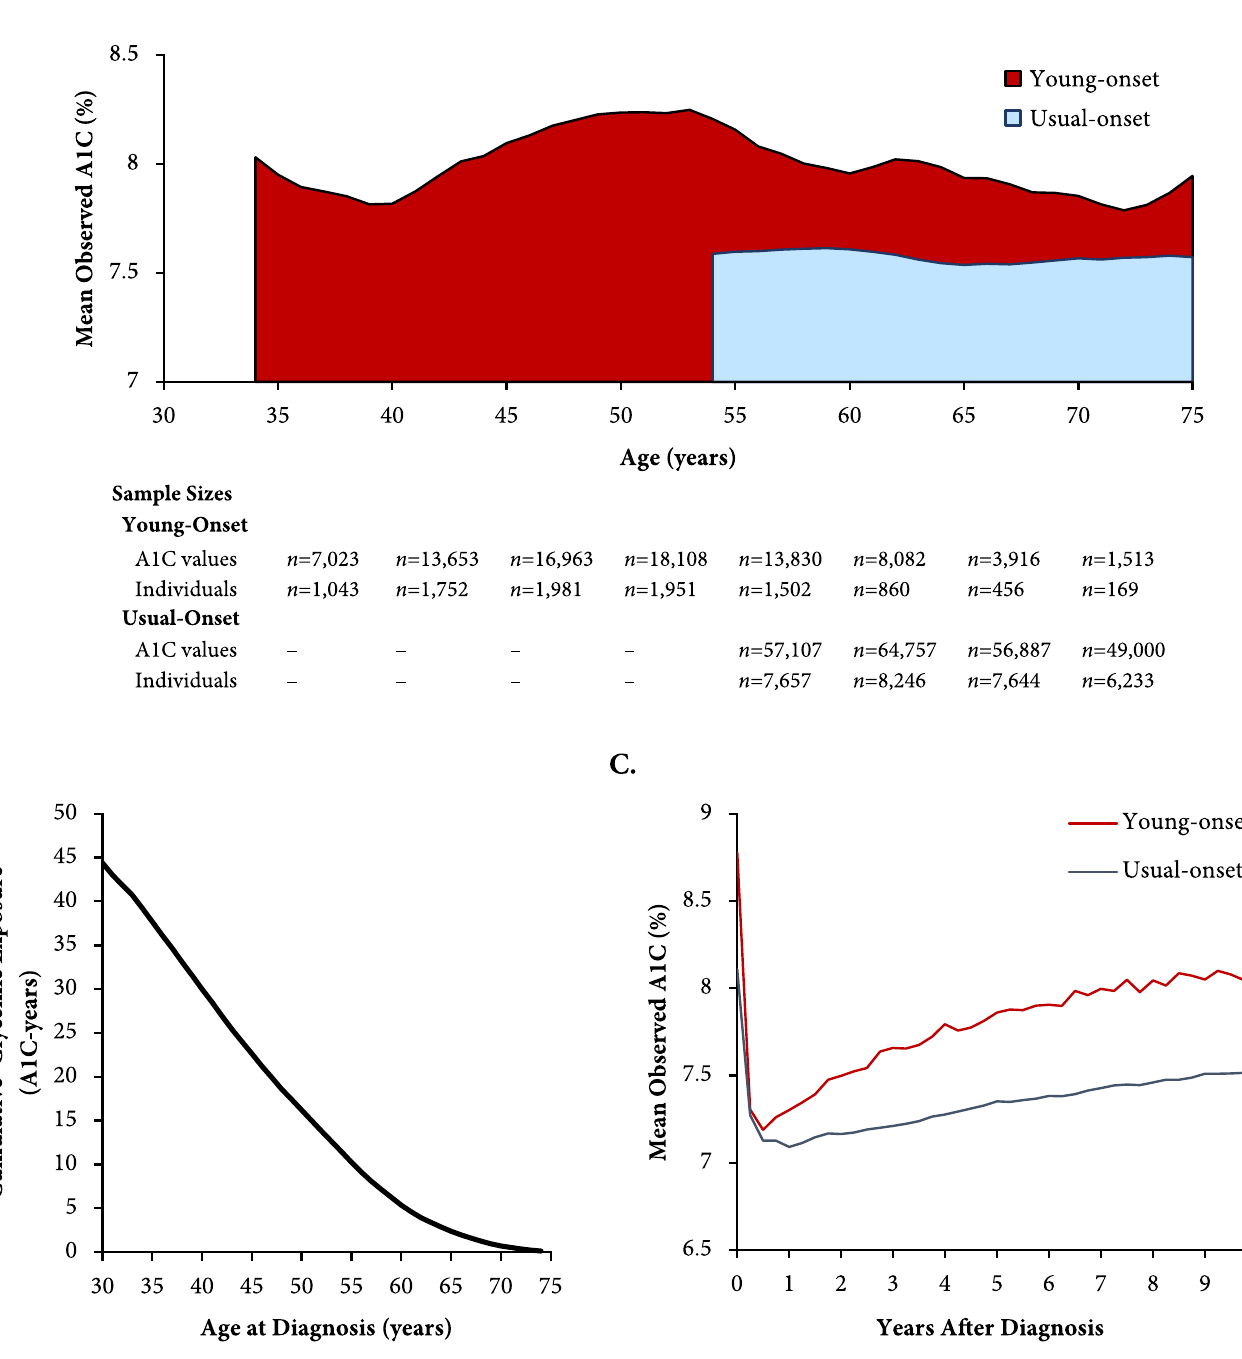
PLOS Medicine| https://doi.org/10.1371/journal.pmed.1003316 September 18,